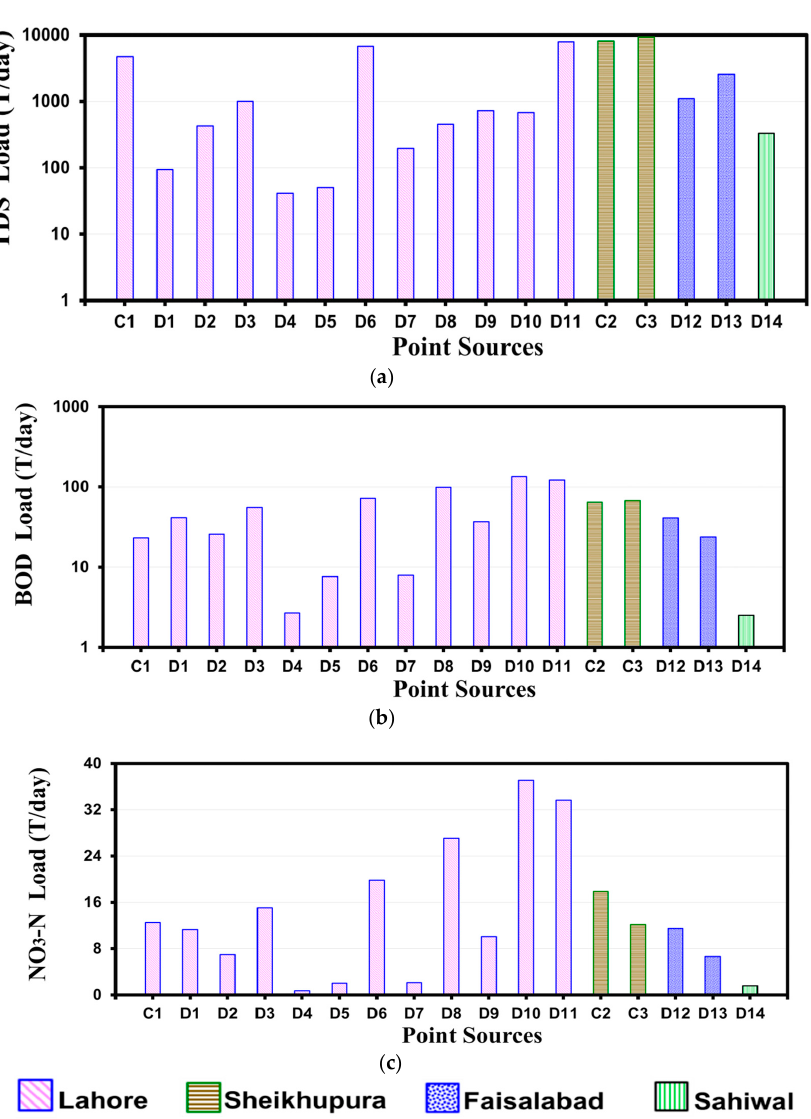
Figure 7. Pollution load contributions of water ‐ quality variables via various link canals and drains along the Ravi River: ( a ) TDS, ( b ) BOD, and ( c ) NO 3 ‐ N.